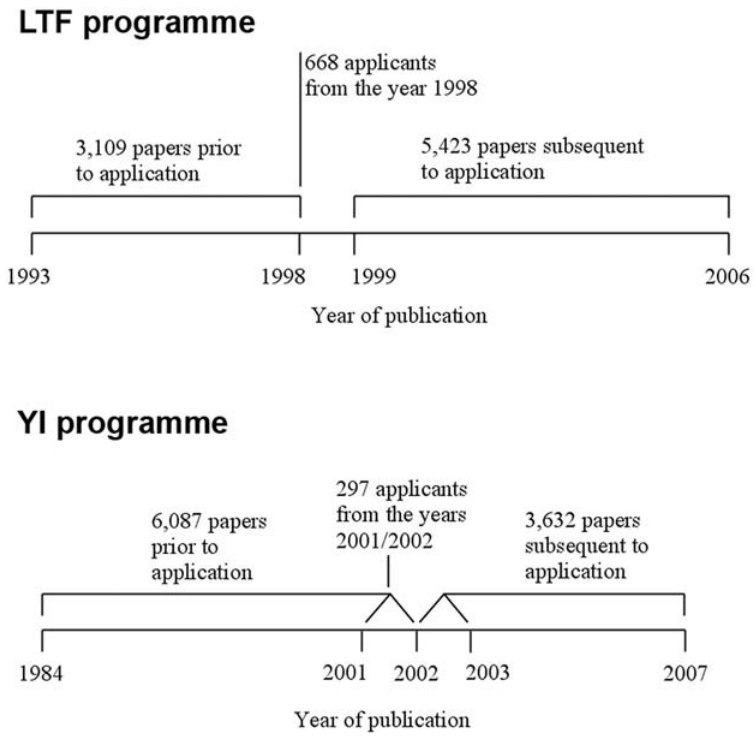
Figure 1. Data structure of this study.